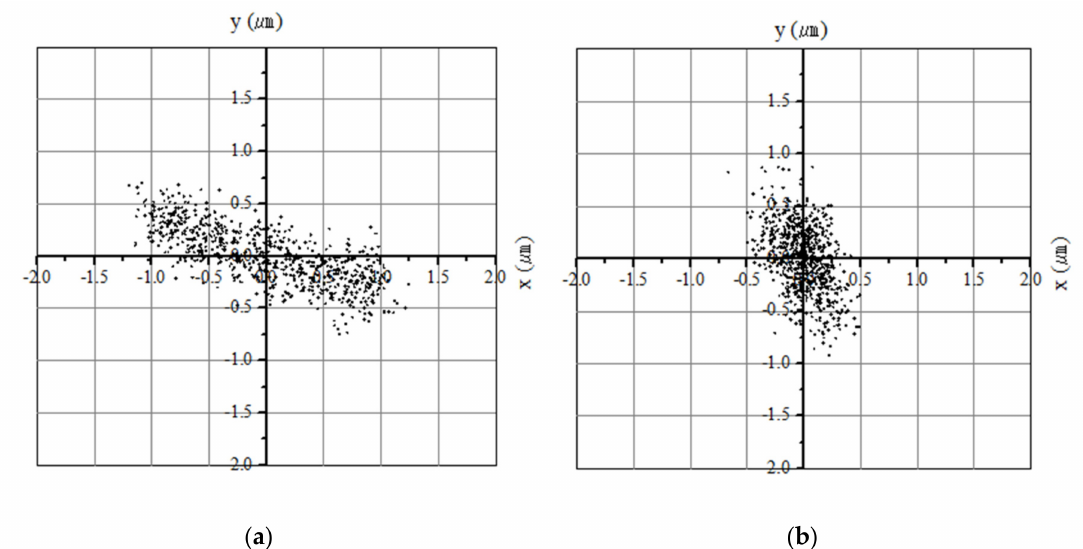
Figure 28. Markers of 15 points on calibration artifact glass for 25 cycles of repeatability test captured by camera: ( a ) without balancing weight and ( b ) with balancing